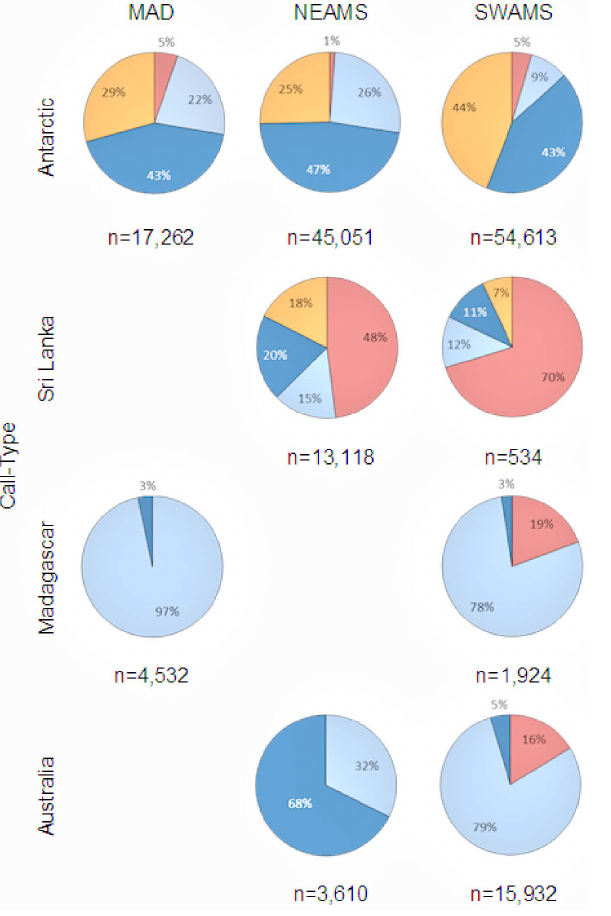
Figure 4. Percentage of detected blue whale calls by location, call type and Southern Hemisphere season for the year 2007 (January to December). Spring (orange), Summer (red), Autumn (light blue), Winter (dark blue).